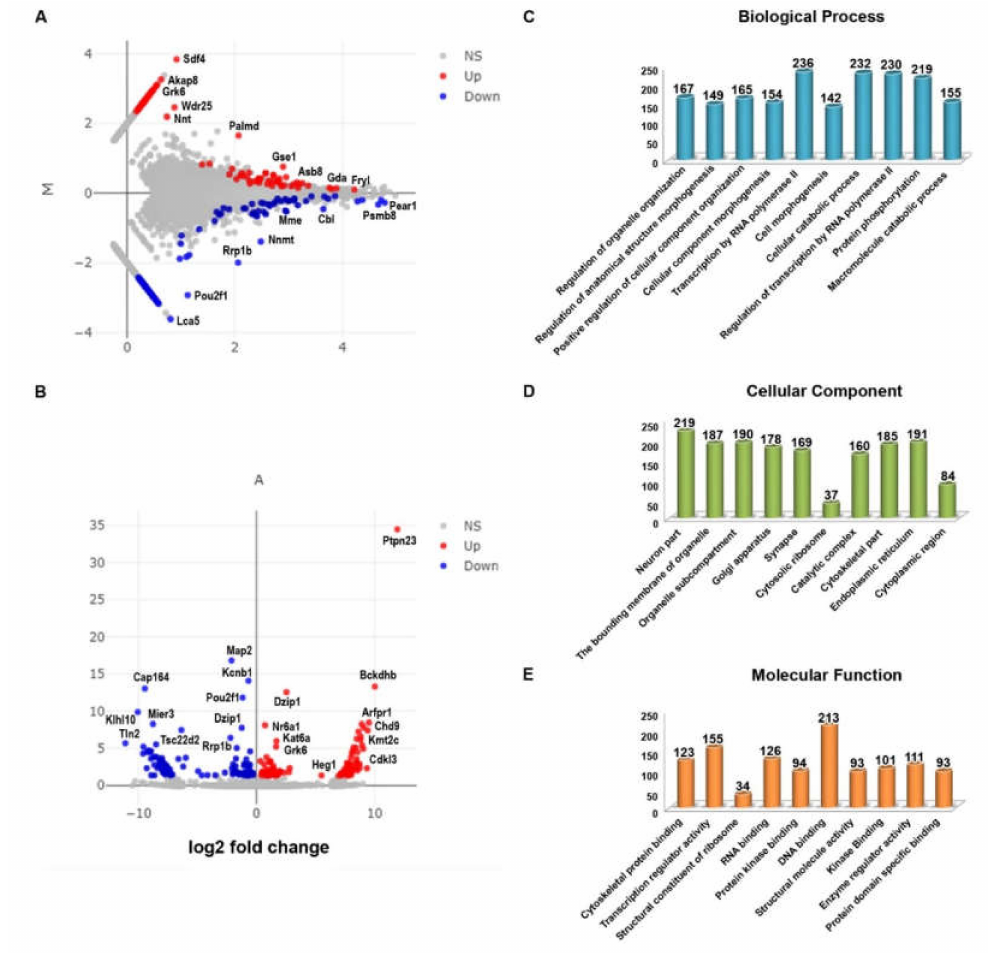
Figure 2. Di ff erentially expressed genes (DEGs) visualization and gene ontology. All detected genes are plotted as an ( A ) MA plot and ( B ) volcano plot. Genes that pass a threshold of p -value < 0.05, padj < 0.05, and log 2 foldChange > 0.2 in di ff erential expression analysis were designated by red (up-regulated) and blue (down-regulated) in KO relative to WT control RPE cells. DEGs involved in various gene ontology enrichment ( C ) biological process, ( D ), cellular component, and ( E) molecular functions, respectively. The FDR < 0.05, p -value < 0.05 are considered as statistical